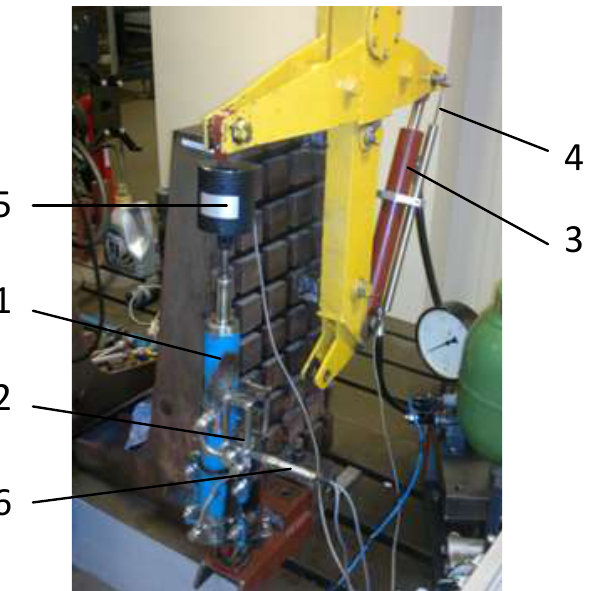
Figure 5. PZD-FT damper built on a test bench: 1—PZD-FT damper, 2—PZV valve, 3—hydraulic actuator working as a kinematic excitation, 4—displacement sensor, 5—force sensor, 6—pressure sensor allowing for pressure readout in the chamber below and above the piston.